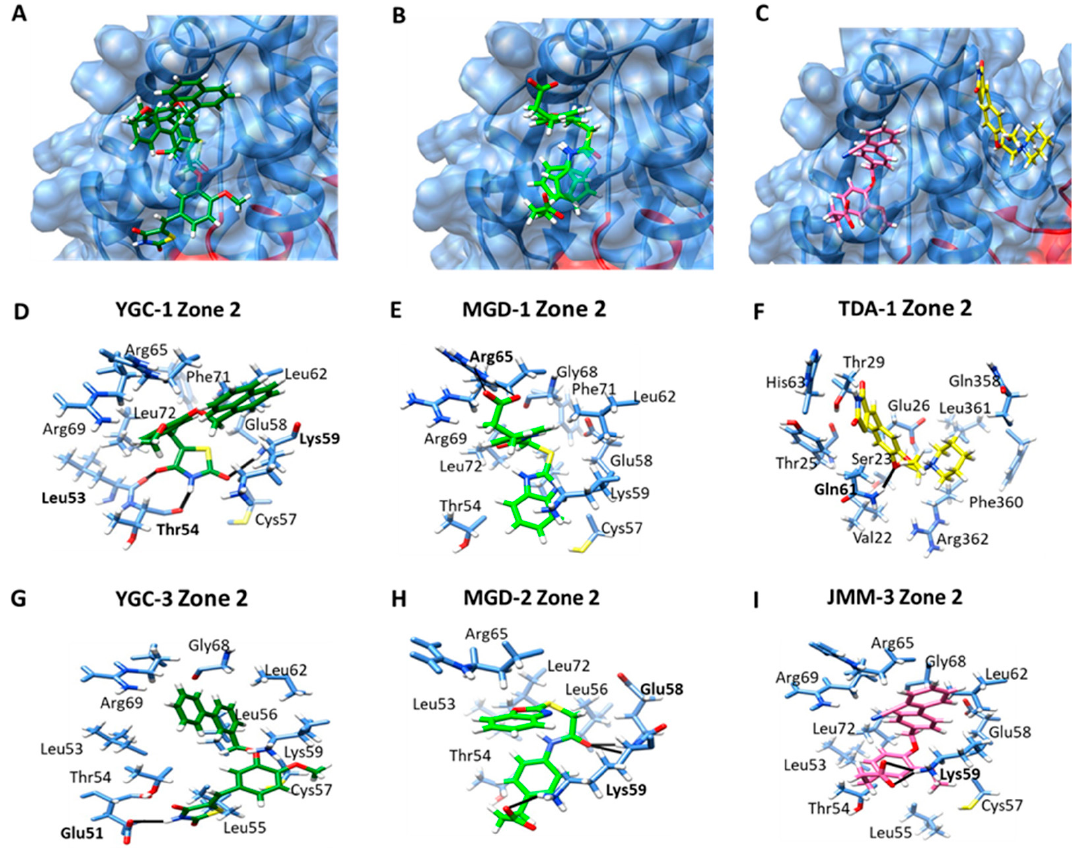
Figure 7. Molecular docking of compounds in zone 2 on the HpG6PD model. A general view of the binding cavities with the HpG6PD protein of ( A ) YGC-1 and YGC-2 ; ( B ) MGD-1 and MGD-2 ; and ( C ) TDA-1 and JMM-3 ; ( D , G ) zoom on the interactions of YGC-1 and YGC-3 ; ( E , H ) zoom on the interactions of MGD-1 and MGD-2 ; and ( F , I ) zoom on the interactions of TDA-1 and JMM-3 ligands with the HpG6PD model. The H-bond interactions are shown in black, and the amino acid residue is marked in